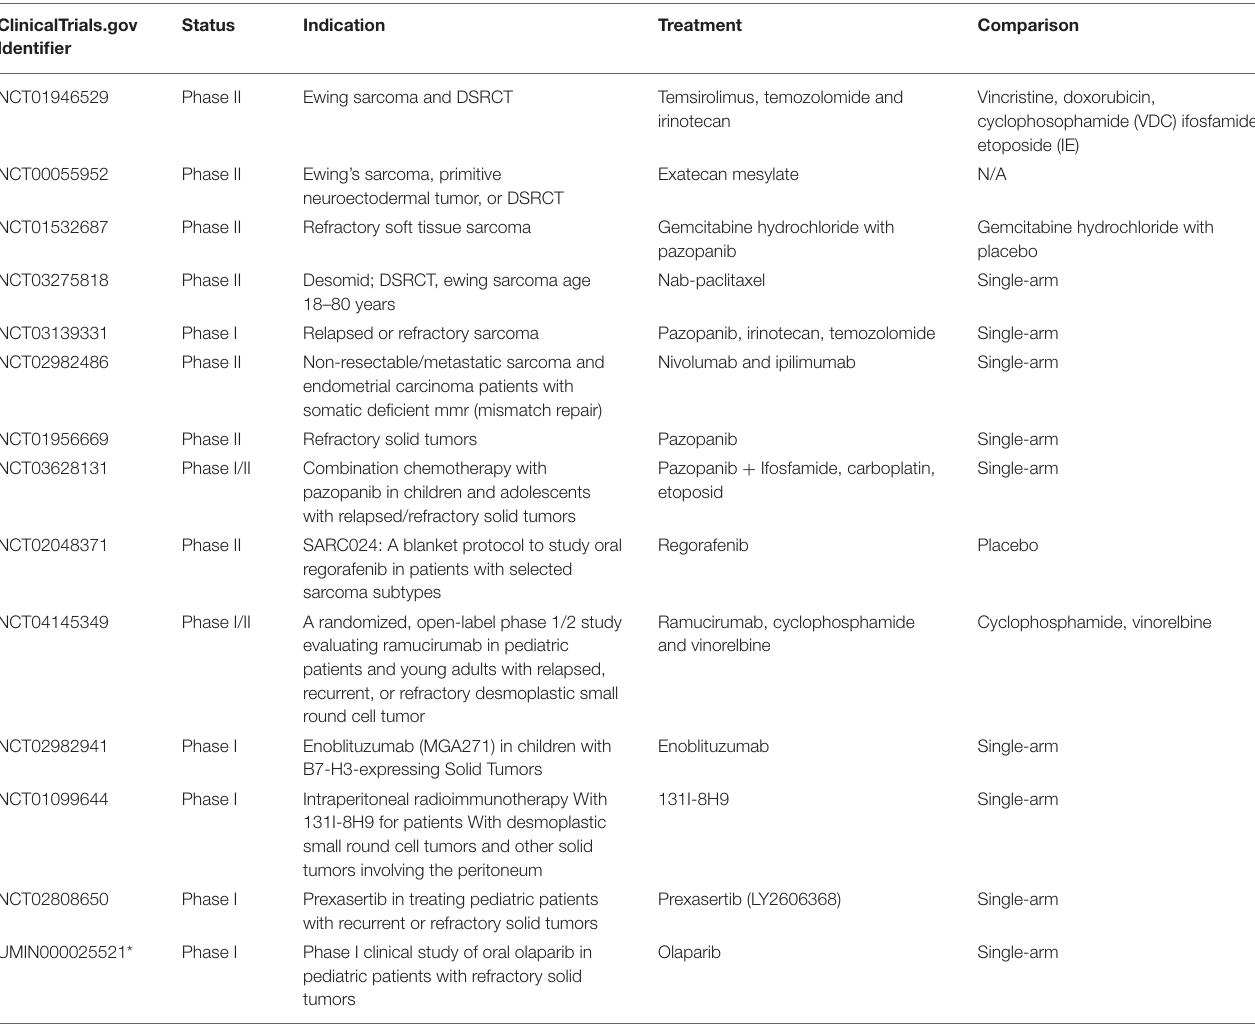
TABLE 2 | Trials including patients with desmoplastic small round cell tumor. ClinicalTrials.gov